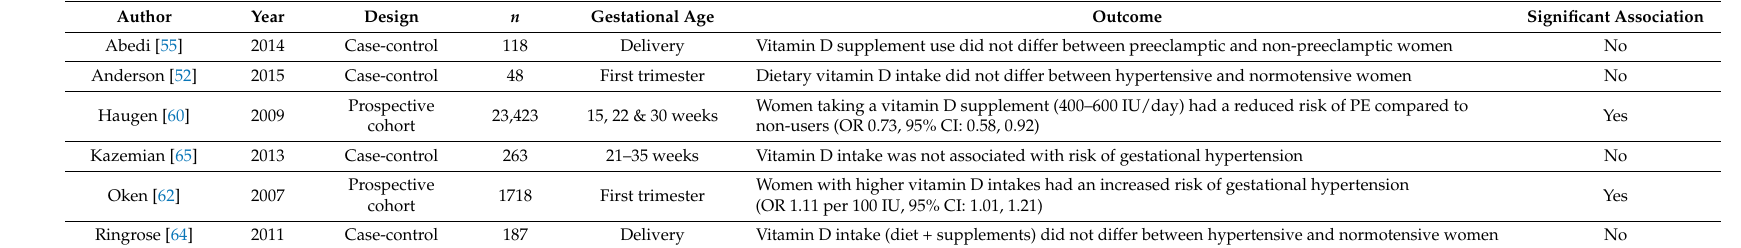
Table 2. Observational studies of dietary vitamin D intake and risk of hypertensive disorders in